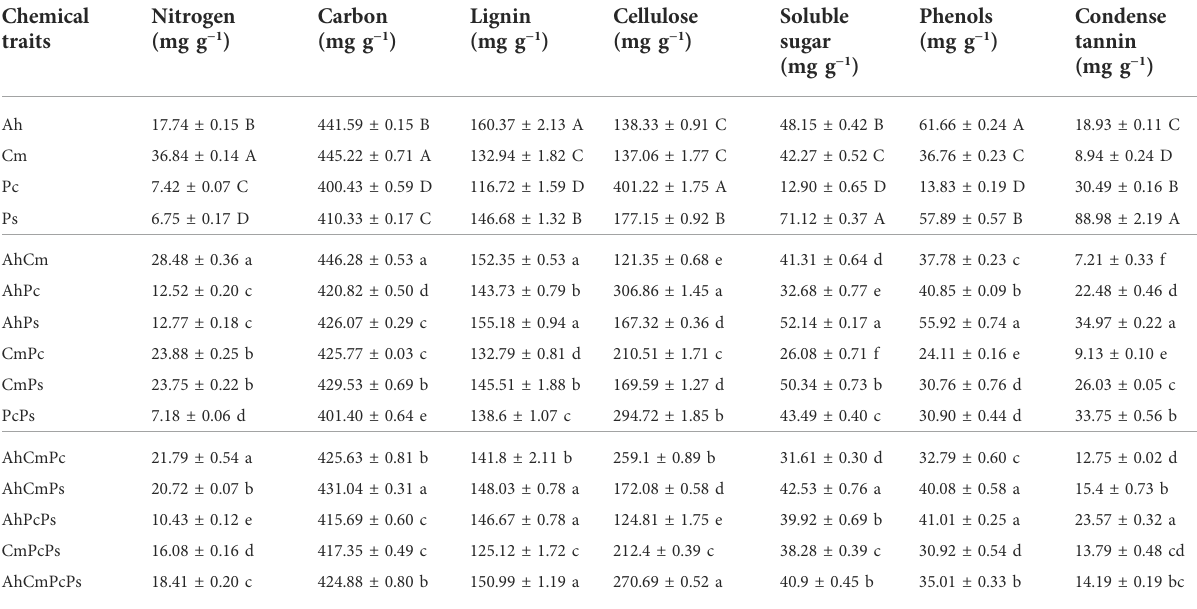
TABLE 1 Initial litter chemistry of the single litter and litter